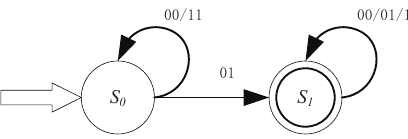
Figure 2. A Deterministic Finite Automaton for r q ⊃ r p .